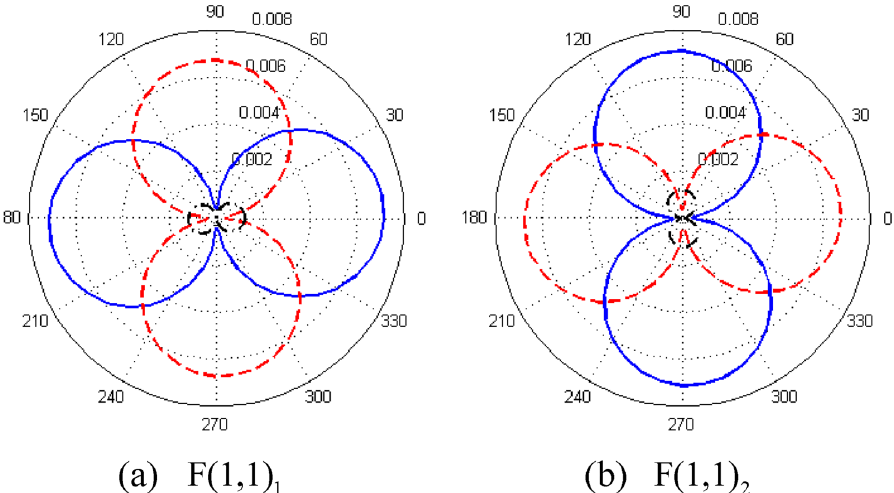
Figure 5. Displacement distributions of ( a ) F(1,1) 1 and ( b ) F(1,1) 2 along circumferential direction (the blue solid, red dotted, and black dashed-dotted lines show the displacements in the radial, circumferential, and axial directions,